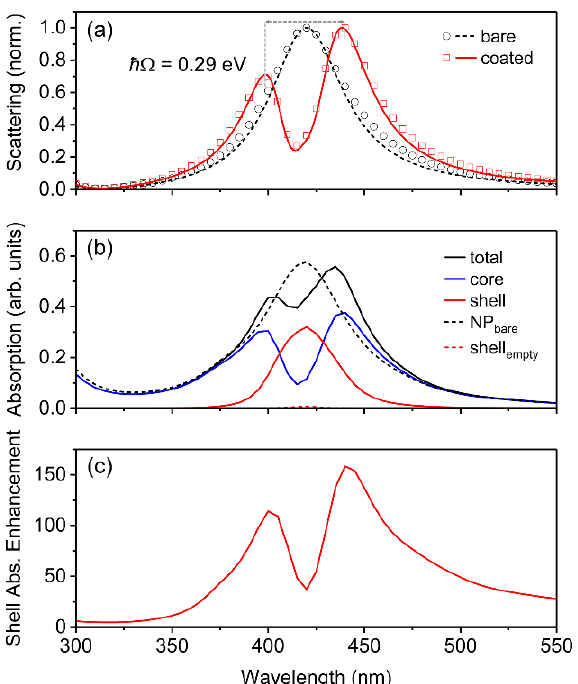
Figure 2. ( a ) Normalized scattering, ( b ) absorption, and ( c ) shell absorption enhancement from core-shell nanoparticles with shell relative permittivity described by a single Lorentzian oscillator. The AgNP radius and shell thickness were r = 25 nm and h = 5 nm, respectively, and the shell parameters used were: λ 0 = 420 nm; f = 0.05; ħ γ = 0.10 eV; ε ∞ = 1.77. Note that ħ Ω represents the splitting energy between the plasmon–exciton hybrid modes, obtained from the scattering spectra, as shown in ( a ). In ( a ), solid lines represent normalized scattering cross-section calculated using analytical Mie theory, and open symbols represent normalized scattering cross-section calculated using numerical finite-di ff erence time-domain (FDTD) simulations. In ( b , c ), only results from the FDTD simulations are shown, using Equation (2) to calculate the absorption in each layer.